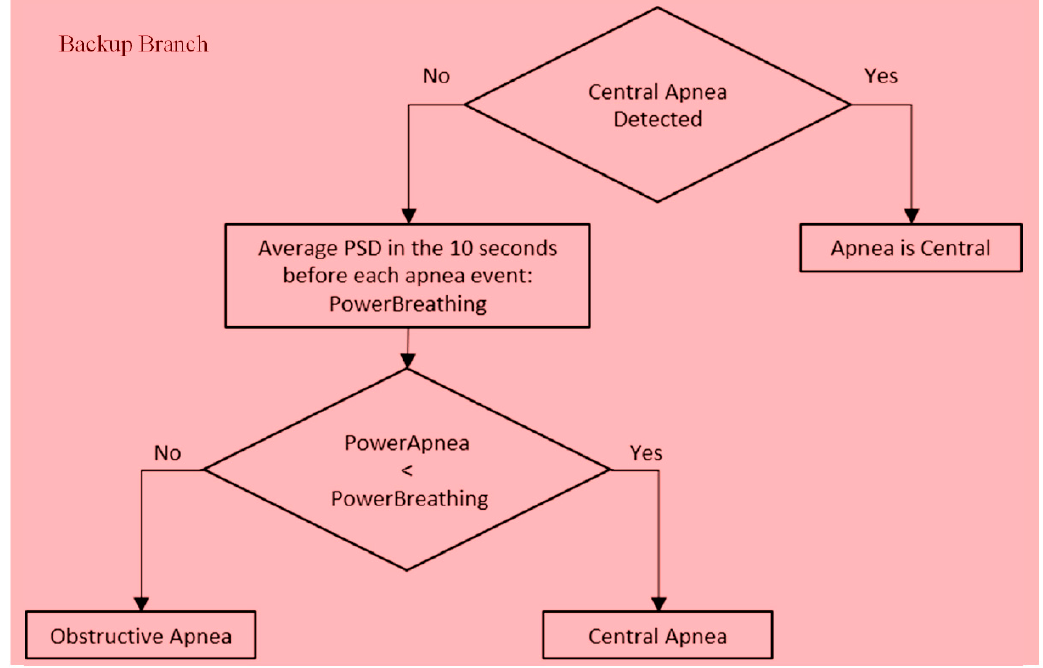
Figure 19. Backup branch in case of no obstructive apneas detected.